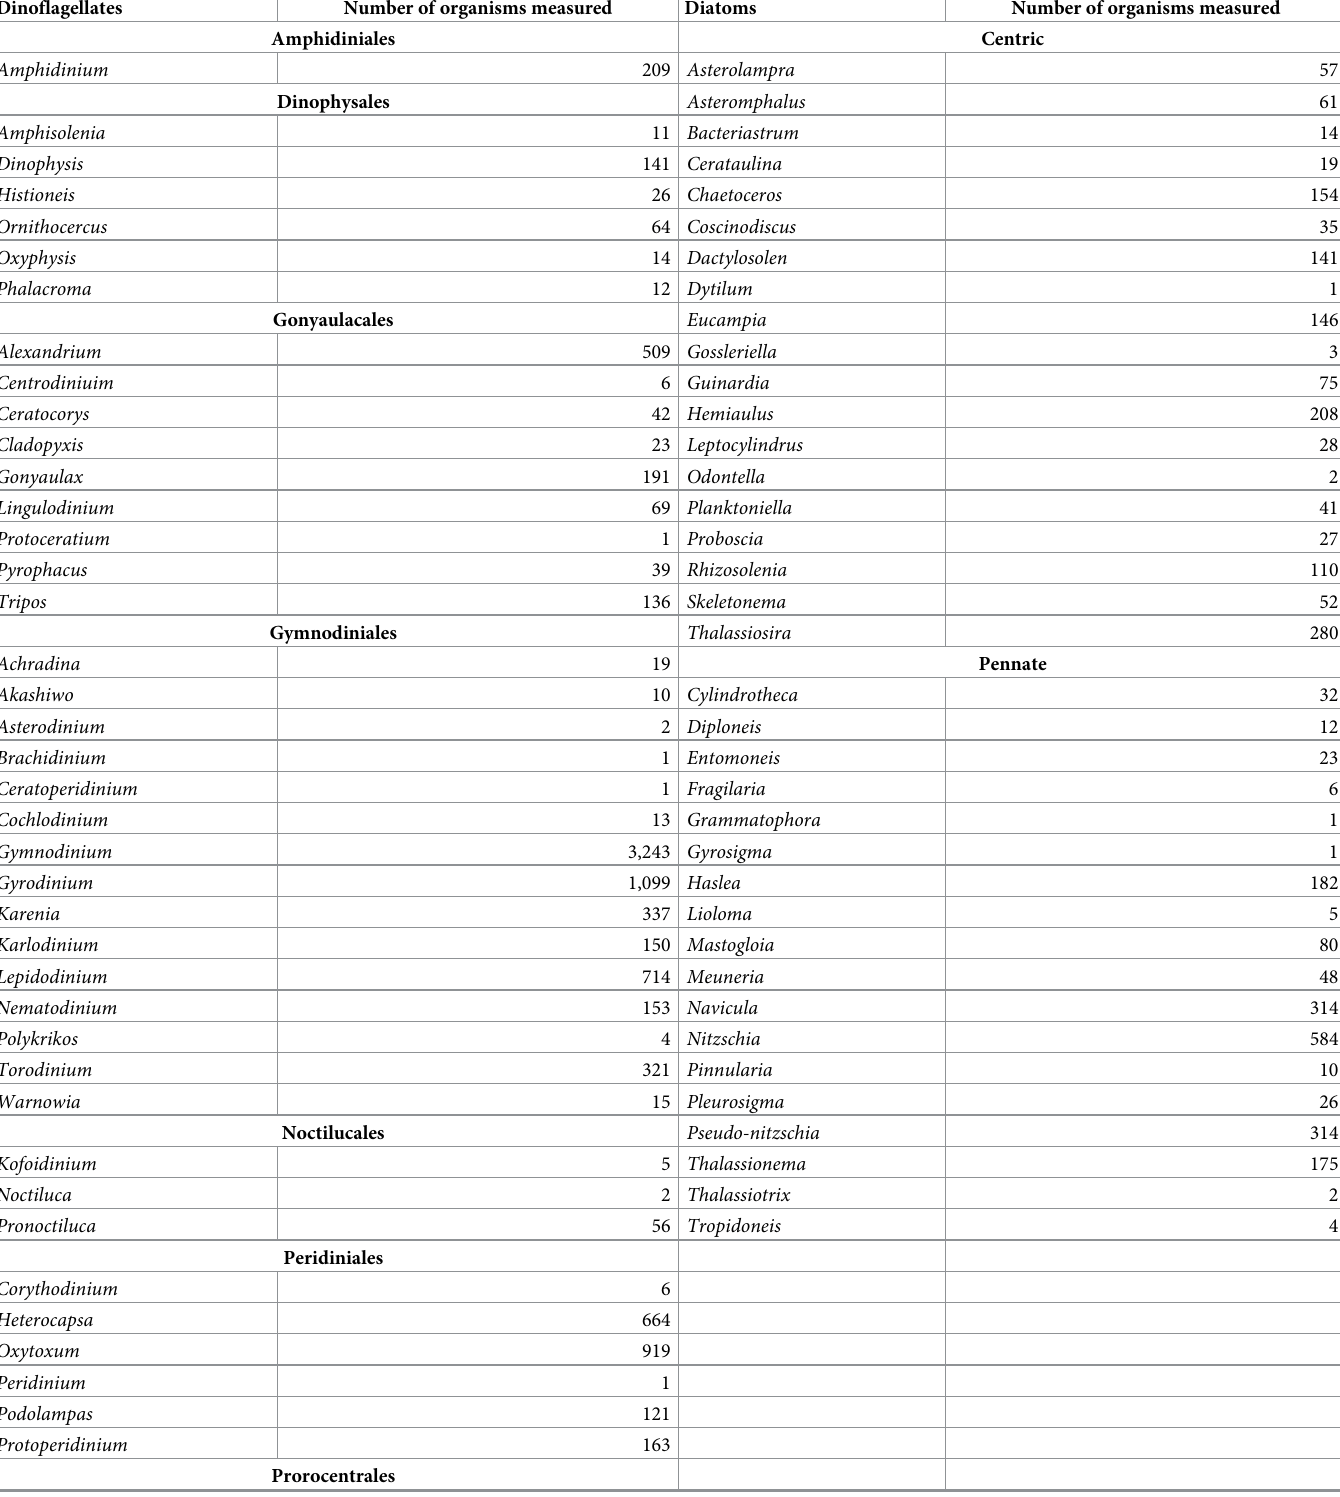
Table 1. Genera of dinoflagellates and diatoms identified and measured in lineal